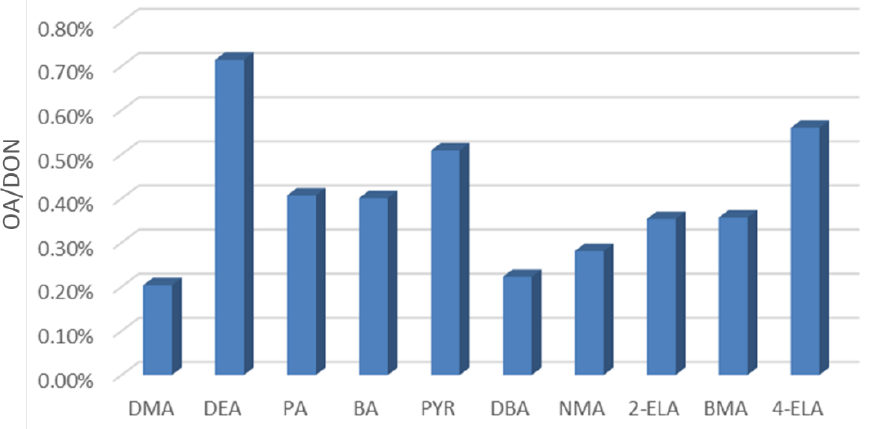
Figure 17. Concentration of ten OA (December 2020–November 2021).